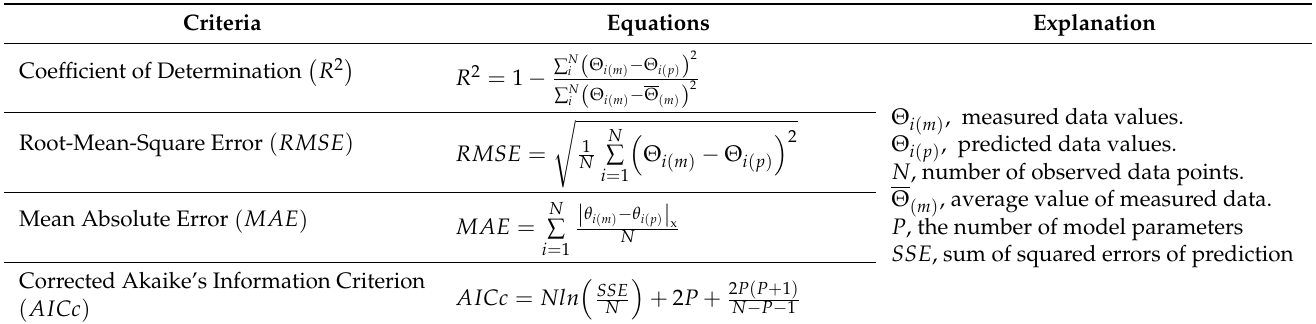
Table 4. The evaluation criteria for model comparison.